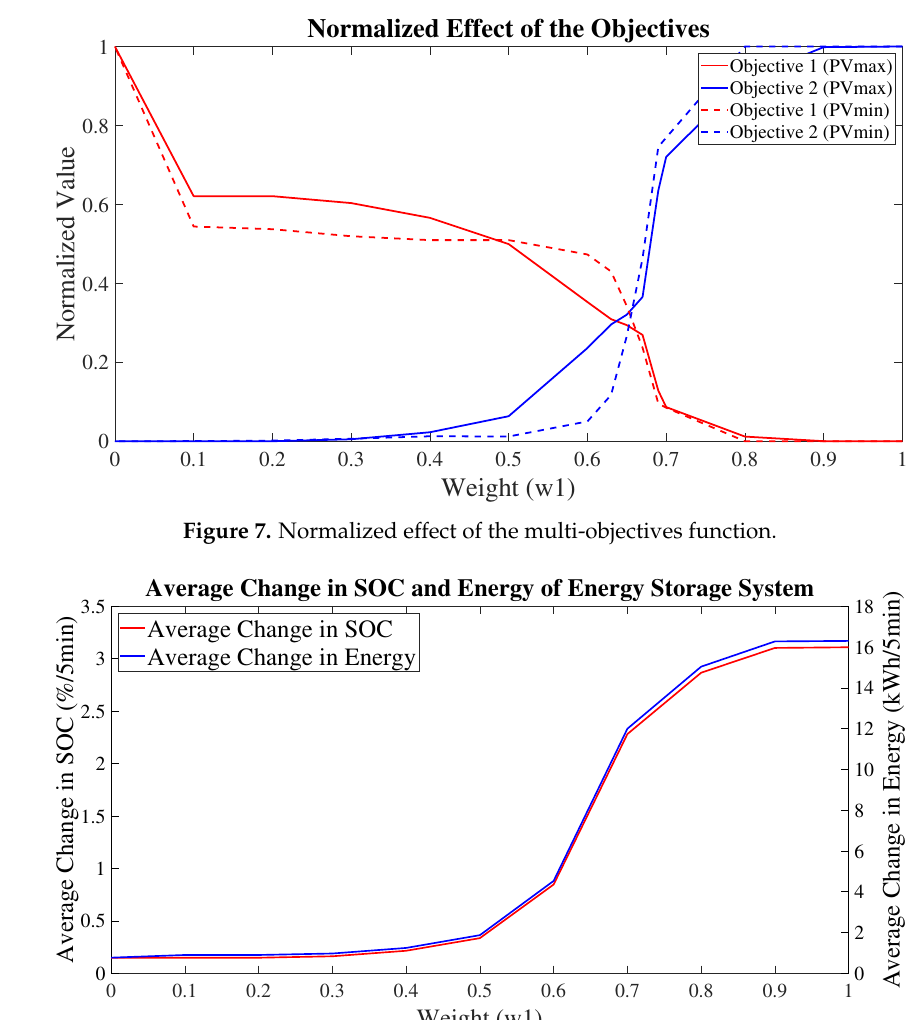
Figure 8. Average change in SOC and energy per unit time step of the energy storage system with varying weight w 1